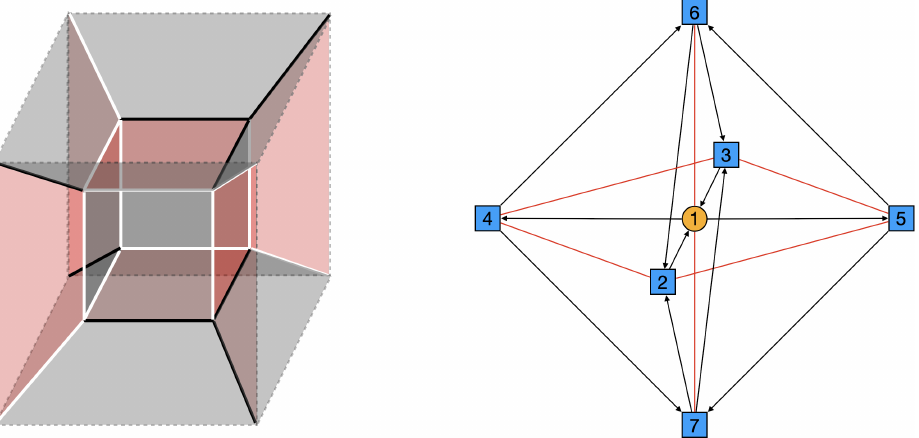
Figure 18 . The cube model and its dual